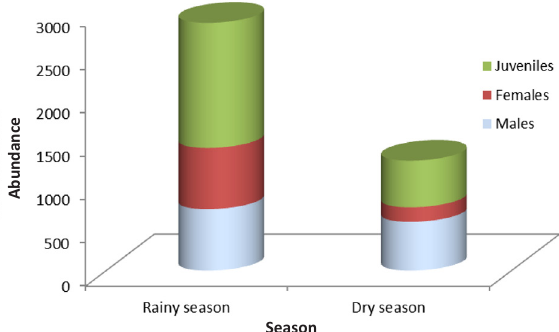
Figure 7. Seasonal difference between adult spiders (males and females) and juveniles abundance in the Ecological Park Centennial Jatoba. (Male: U=9213, P=0.32; Female: U=6654, P<0.0001; Juveniles: U=9285, P=0.36)